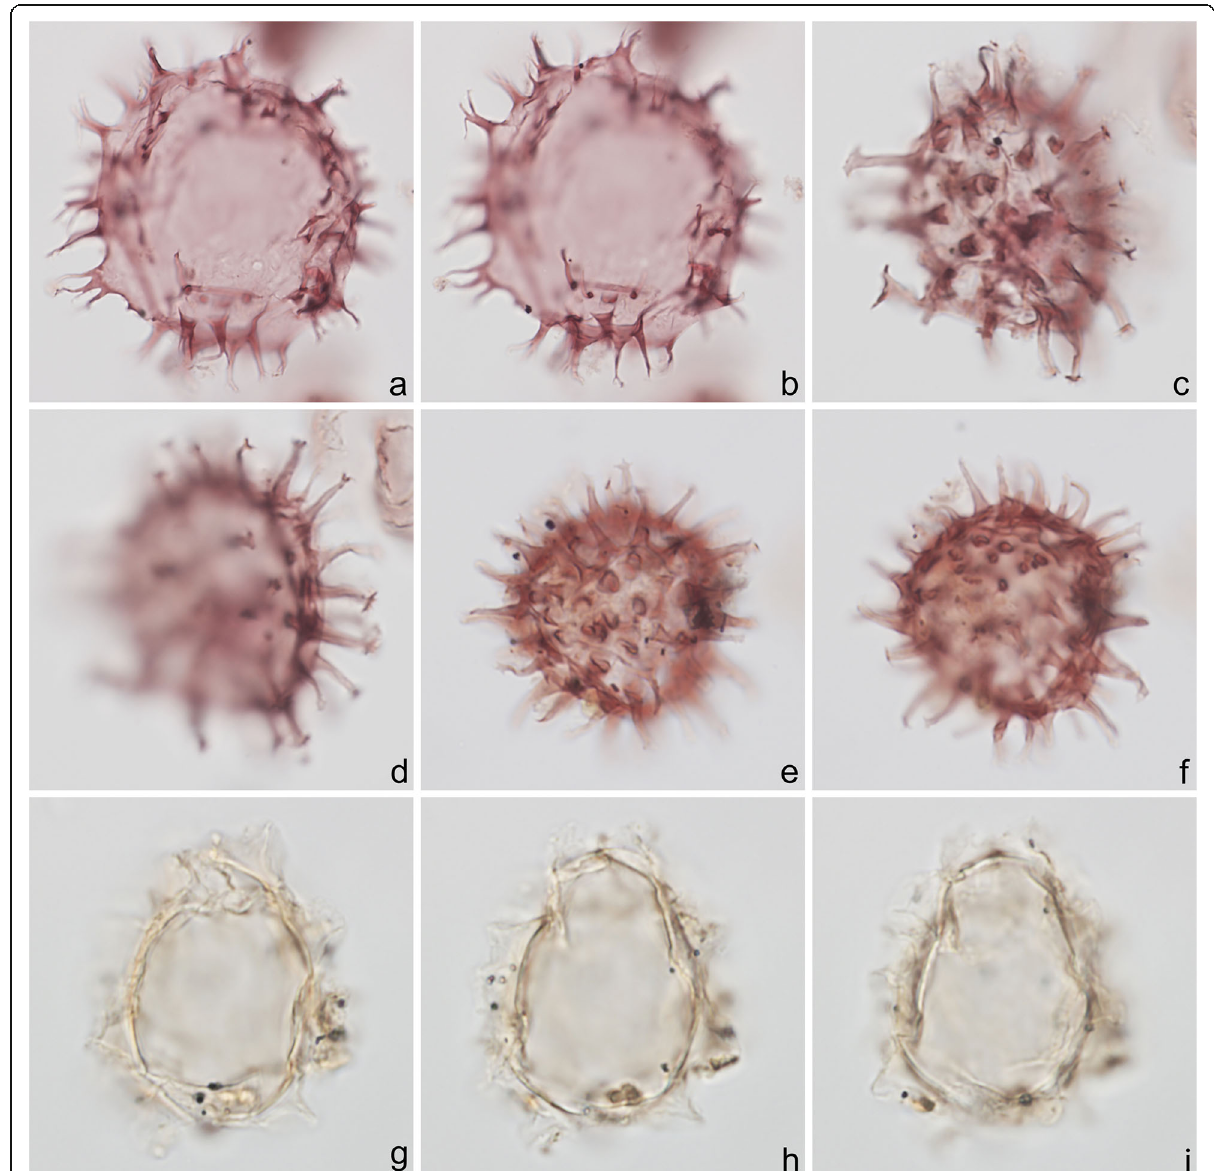
Fig. 13 Dinoflagellate cysts from the Chiba composite section. Max. dia. = maximum diameter. EF = England Finder reference. a , b Xandarodinium xanthum , uncertain view at upper and lower foci; central body max. dia. 52 μ m; sample TB 18, slide 1 (10 μ m), EF F22/2. c – f Echinidinium aculeatum ; c , d uncertain view at upper and lower foci; central body max. dia. 27 μ m; sample TB 42 slide 1 (10 μ m), EF N29/2; e , f uncertain view at upper and lower foci; central body max. dia. 23 μ m; sample TB 16, slide 2 (10 μ m), EF E42/0. g – i Cyst of Scrippsiella trifida , lateral view at upper, mid-, and lower foci; central body length 29 μ m; sample TB 56, slide 2 (10 μ m), EF